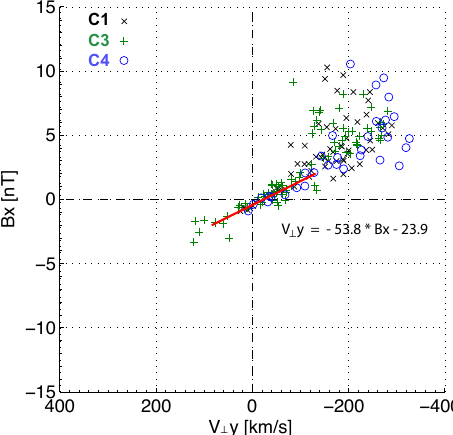
Figure 7. V ⊥ y versus B x during the main Earthward flow (continu- ously V ⊥ x > 100kms − 1 ) for each spacecraft. The red line indicates a linear fit to data points close to the neutral sheet ( − 2 ≤ B x ≤ 2nT).